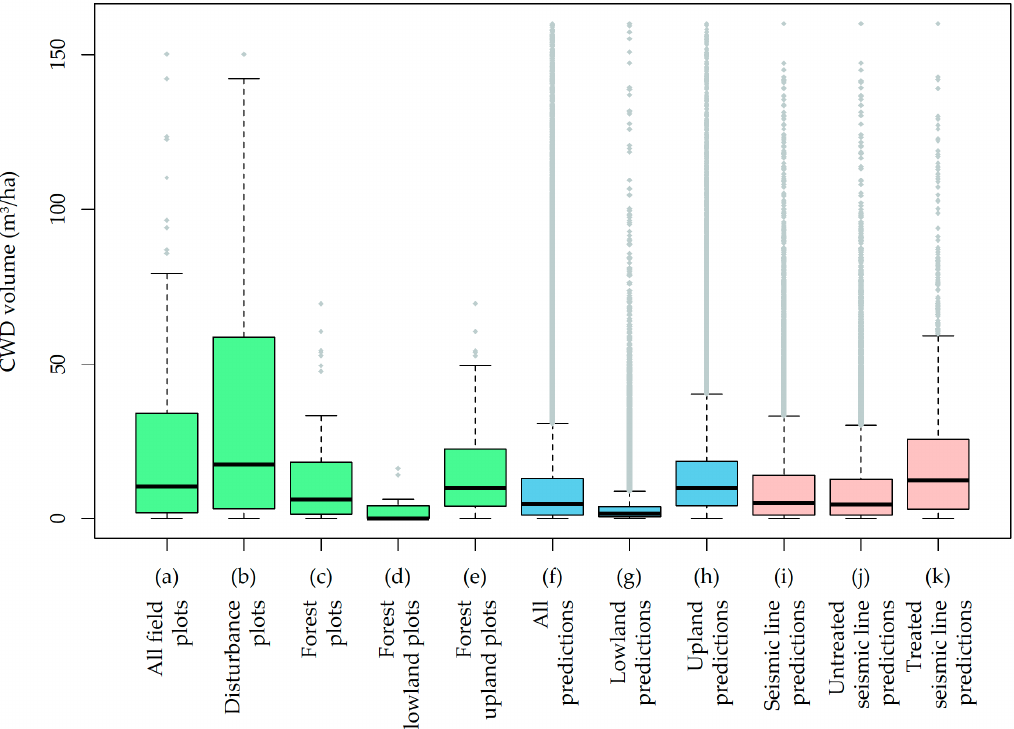
Figure 6. Box and whisker diagram for coarse woody debris (CWD) volume on reference data (green, total of 108 field plots) on the CWD map for the entire application area (blue, total of 379,025 cells) and on seismic lines (red, 63,816 sampling points). All reference data ( a ) are divided into ( b ) disturbance plots (54 plots) and ( c ) forest plots (54 plots). Forest plots are divided into ( d ) lowland plots (14 plots) and ( e ) upland plots (40 plots). All map predictions ( f ) are divided into ( g ) lowland (38% of cells) and ( h ) upland (62% of cells) predictions. Seismic line predictions ( i ) are divided into ( j ) untreated lines (90% of samples) and ( k ) treated lines (10% of samples). Original values were in m 3 / 100m and were projected to m 3 / ha. Box-plot outliers are presented in gray.